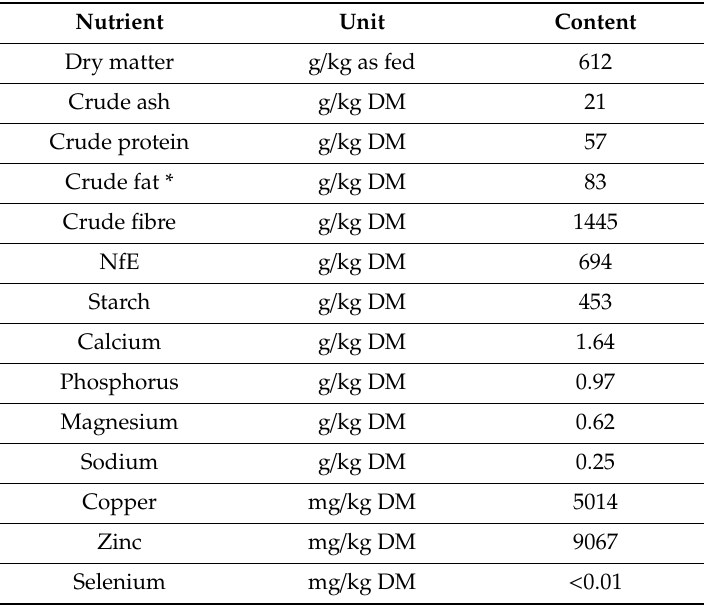
Table 1. Analysed nutrient composition of pure